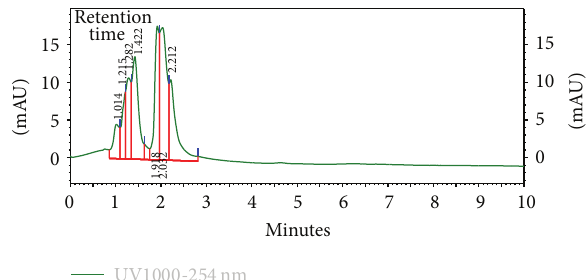
Figure 2: HPLC chromatogram (finger-printing) of methanol stem bark extract (KASB) of K. africana at 𝜆 254 nm.